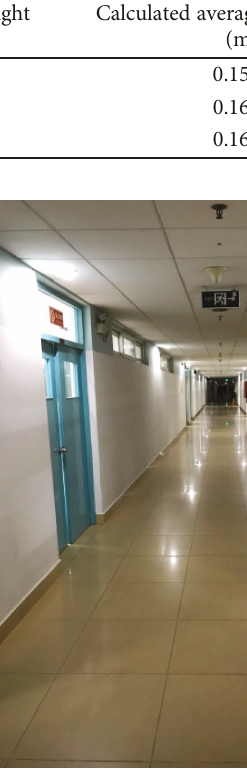
Figure 7: Experimental environment in Case 1.